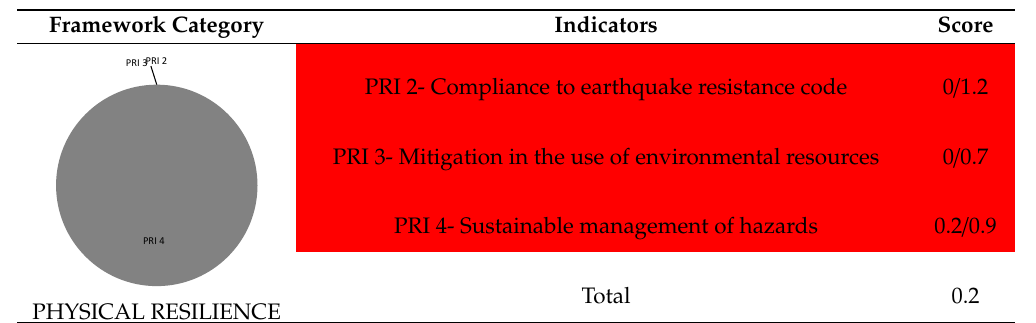
Table 15. RAG rating of Physical Resilience Indicator in Louroujina.